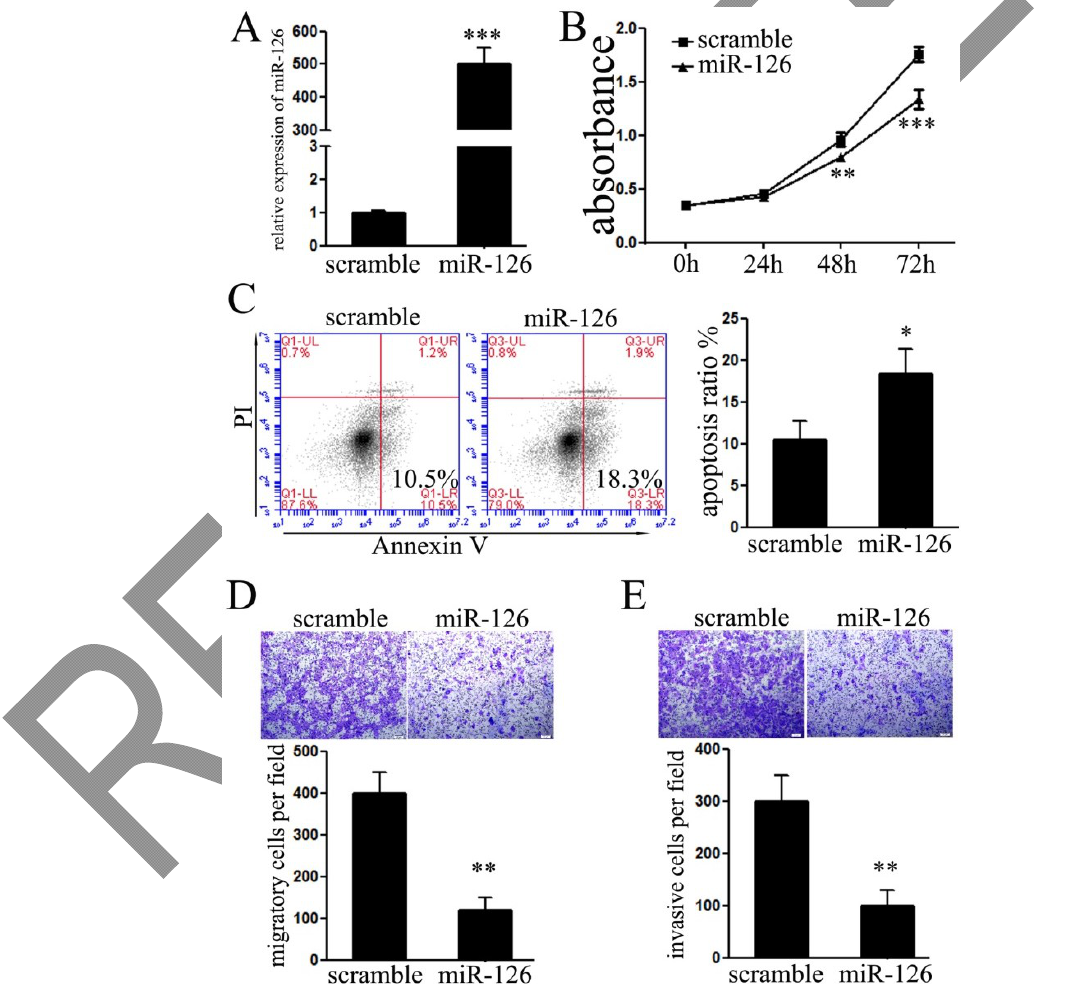
Figure 2. miR-126 suppresses OS tumor progression. ( A ) RT-PCR was performed to detect the expression of miR-126 in OS cell line MG-63 after treatment with mimic. Upon transfection with the miR-126 mimic, the expression of miR-126 in MG-63 cells was restored; ( B ) CCK-8 was performed to analyze the effect of miR-126 on cell proliferation of MG-63 cells. Ectopic expression of miR-126 inhibited cell proliferation; ( C ) The influence of miR-126 on cell apoptosis was analyzed using cell apoptosis assays. Transfection with miR-126 showed more cells undergoing early apoptosis; and ( D , E ) The effects of miR-126 on cell migration and invasion were detected using transwell chamber assays. Panel D showed the results on migration. Over-expression of miR-126 dampened cell migratory capacity with suppressing cells passed through the membrane; Panel E showed the results on invasion. The chambers have been coated with Matrigel, which functions as the extracellular cell matrix. miR-126 inhibited cells invasion through